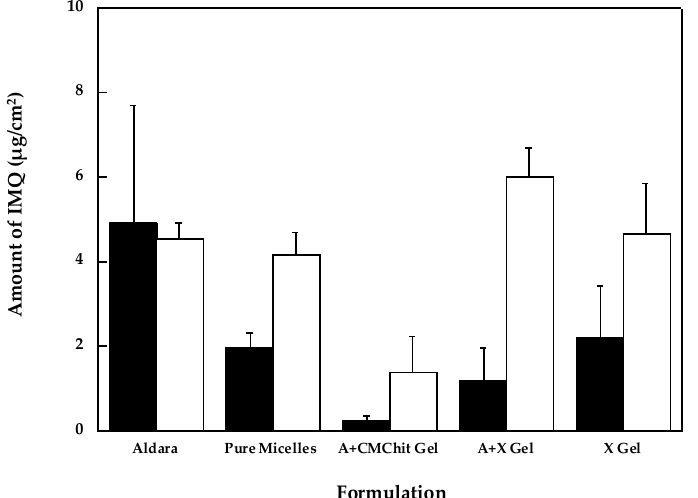
Figure 1. IMQ retained (dark bar) and permeated (light bar) across porcine esophageal epithelium from gels (mean ± sd).